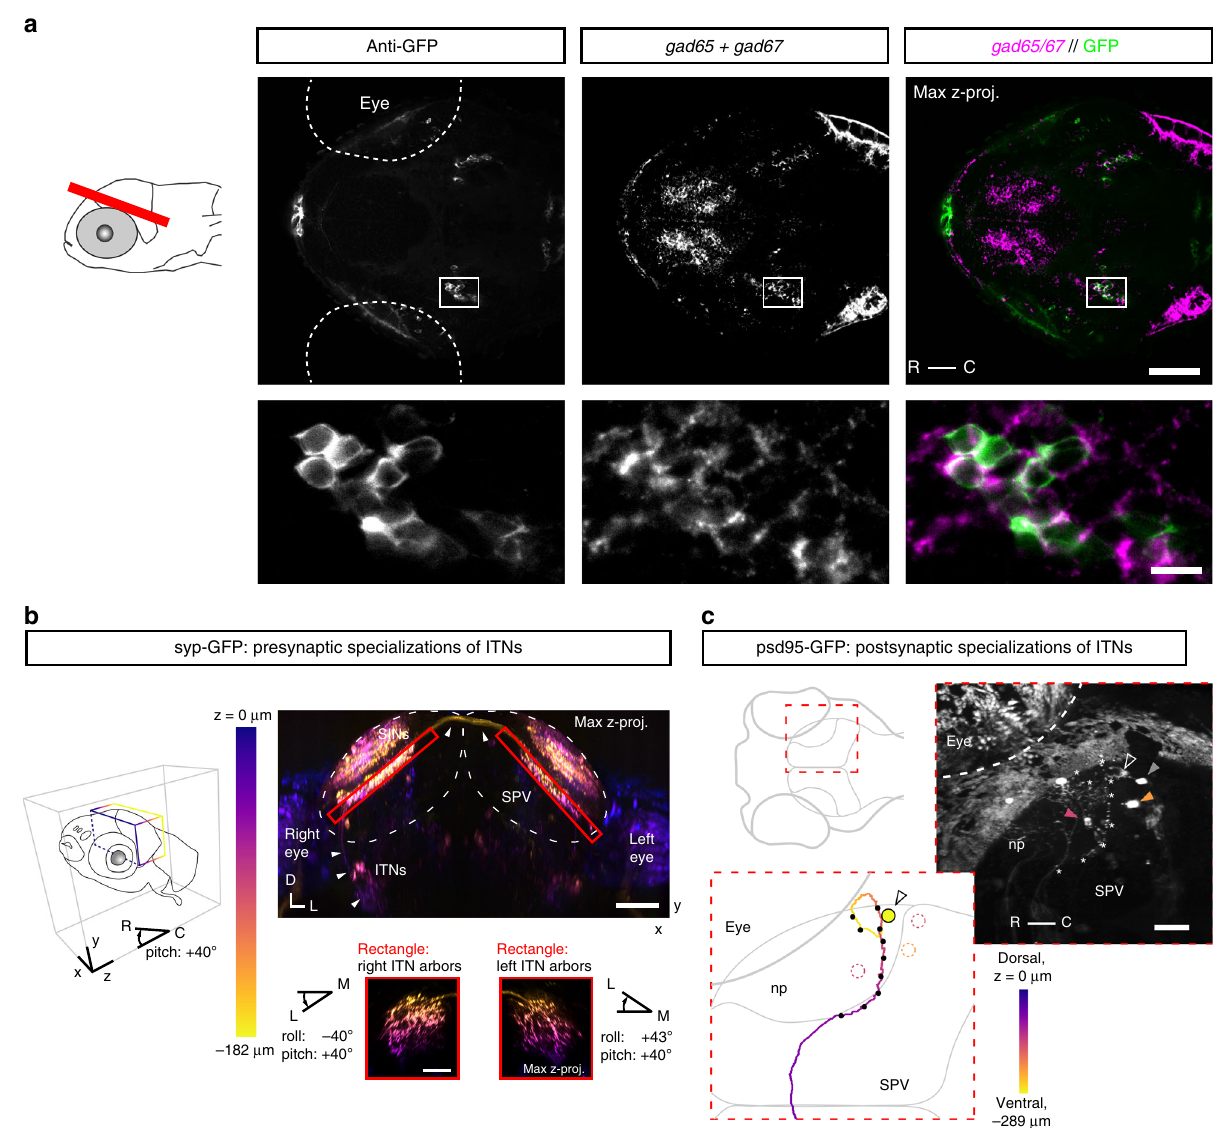
Fig. 3 Intertectal neurons are GABAergic interneurons and form pre- and post-synaptic specializations in the OT. a Expression of gad65 / gad67 and anti- GFP immunoreactivity in the brain of a 4 dpf ITN Gal4, UAS:GCaMP3 larvae (red bar in larva to the left indicates microscopic plane, scale bar = 50 μ m). Two bilateral symmetric ITN nuclei are labeled by anti-GFP (left nucleus enlarged and shown in the lower images, scale bar = 10 μ m). b Maximum intensity projection through the OT of a 5 dpf ITN Gal4, UAS:GCaMP3, UAS:Syp-GFP) larva (view from the front and below of the larva). Syp-GFP signal is color-coded according to depth along z . Pre-synaptic specializations of ITNs (Syp-GFP puncta, red rectangles) are in the deep neuropil ipsi- and contralaterally to the ITN cell bodies. Small panels: maximum intensity projections of the pre-synaptic specializations of ITNs viewed dorso-laterally (larva fi rst rotated along the roll axis by − 40° for right ITN arbors or along the roll axis by 43° for left ITN arbors, then rotated along the larval pitch axis by + 40°, color code according to depth in z ). White arrows indicate the ITN axon tract. Syp-GFP-labeled puncta in upper layers of the tectal neuropils belong to super fi cial interneurons (SINs) in the SO and SFGS 54 . All scale bars = 50 μ m. c Postsynaptic specializations labeled in a 3 dpf ITN Gal4 UAS:GCaMP3 larva, transiently expressing UAS:psd-95-GFP . Right panel shows a maximum intensity projection viewed dorsally through the right OT (skin auto fl uorescence partially removed). A single ITN was labeled in this larva (cell body indicated by open white arrow) and locations of puncta with strong psd-95-GFP expression are indicated by white asterisks along the ITN neurite. The ITN was traced and its trajectory color-coded according to the position in the dorsoventral z -plane (lower-left inset). Black dots along the neurite indicate the positions of psd-95-GFP puncta. Post-synaptic specializations of ITNs were found predominantly in the deep layers of the tectal neuropil ipsilateral to the ITN cell body. Periventricular neuron cell bodies (PVNs) were sometimes labeled in ITN Gal4 larvae (dotted circles or fi lled arrows color-coded according to their z -position in right panel). Scale bar = 30 μ m. (np: tectal neuropil, R: rostral, C: caudal, D: dorsal, L: left, SO: stratum opticum , SFGS: stratum fi brosum et griseum super fi ciale , SPV: stratum periventriculare